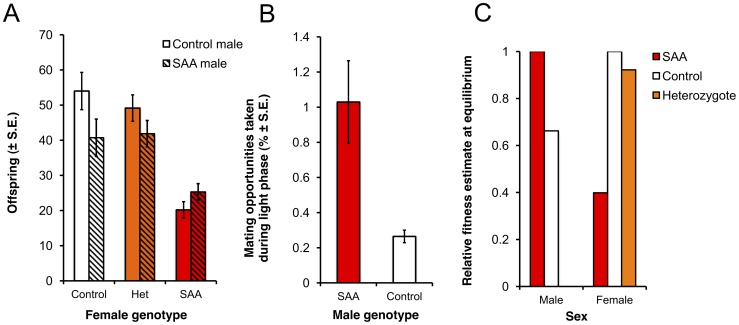
Reproductive success of male and female genotypes.(a) Homozygote sexually antagonistic allele (SAA) females suffer reproductive success costs compared to control and heterozygote females (F2,168 = 55.4, p<0.0001). Furthermore, reproducing with control males rather than SAA-males exacerbates the relative cost to SAA-female reproductive success (male*female: F2,168 = 5.27, p = 0.07). (b) SAA-males have a photophase mating advantage over control males in P4-P4 (χ2
1 = 35.58, p<0.0001) (c) Estimates of relative fitness at the SAA equilibrium frequency (12.6%) for males and females of different genotypes. Relative fitness is calculated from the population genetic model for a 12∶12 light∶dark cycle. Note that the relative fitness of males is adjusted for scotophase, during which time the mating success of SAA and control males is equal. Therefore, the overall advantage to SAA males is lower than in photophase only (as shown in b) and the predicted fitness cost of SAA to homozygote females exceeds the predicted fitness benefit of SAA to males.